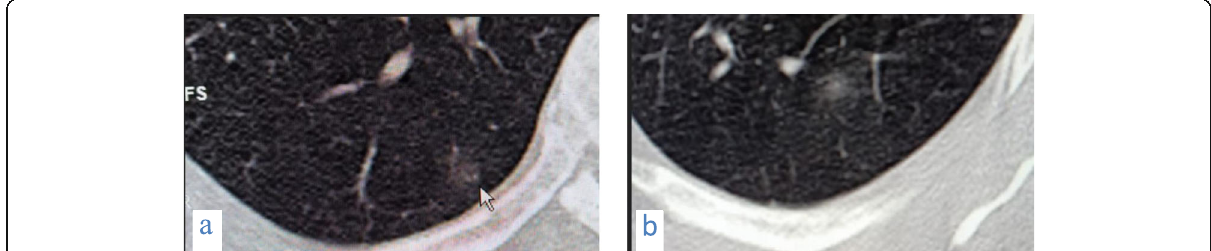
Fig. 2 A 56-year-old male patient with COVID-19, CT chest magnified axial images showing ( a ) small fairly rounded subpleural ground glass opacity in the right lower lobe (arrow) and ( b ) a left lower lobe fairly rounded peripheral small ground glass